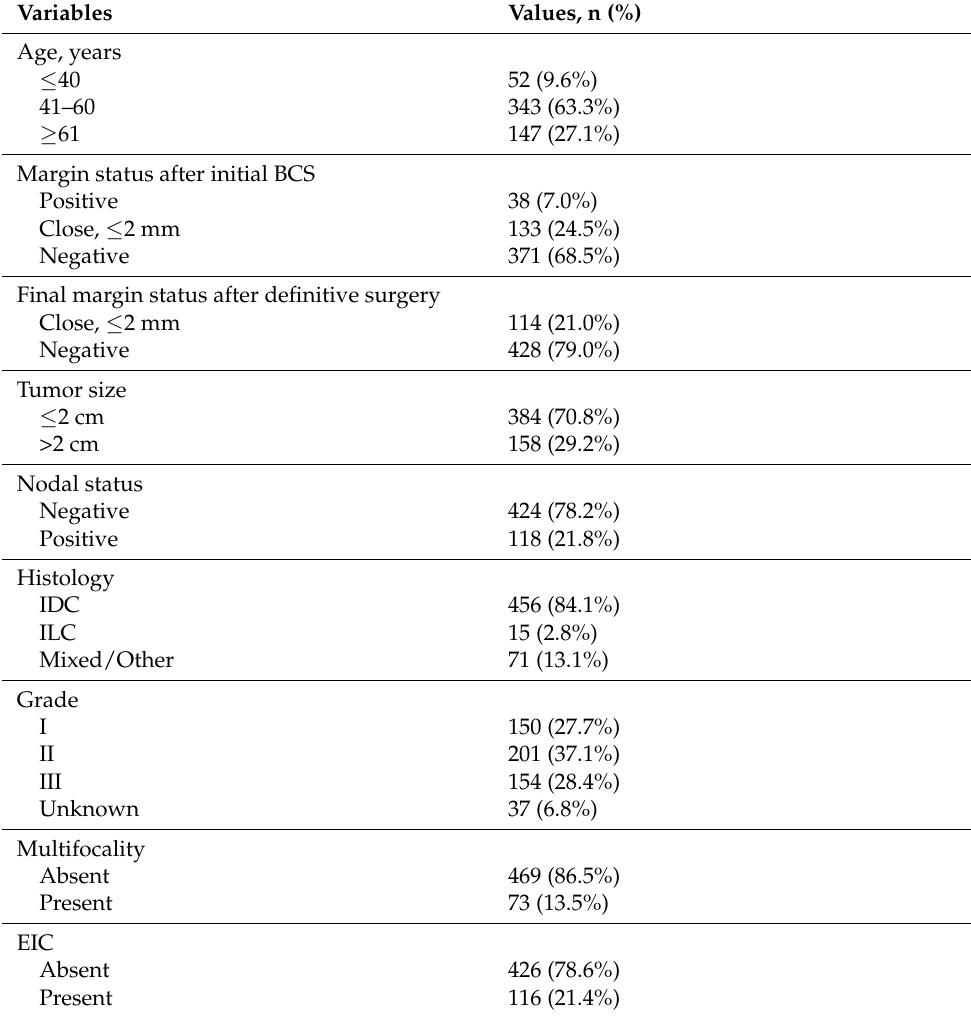
Table 1. Patients’ clinicopathological